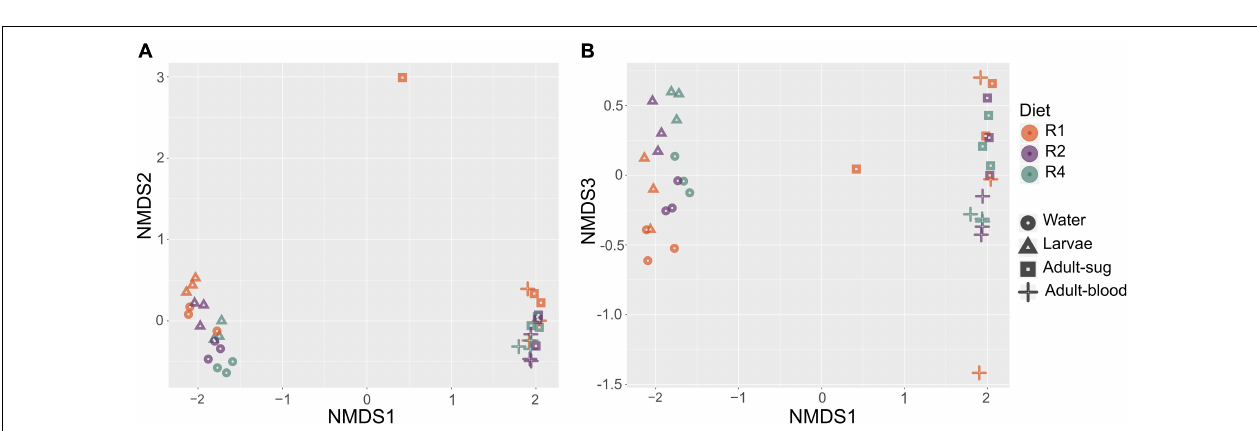
FIGURE 5 | Non-metric multidimensional scaling analysis reveals clustering by sample type and larval diet regimen. We performed NMDS analysis using Bray-Curtis dissimilarity values. Plots show axes 1 and 2 (A) and axes 1 and 3 (B) . Color is used to indicate diet regimen (orange = R1, purple = R2, green = R4) and shape is used to indicate sample type (circle = breeding water, triangle = larvae, square = adult sugar fed midguts, cross = adult blood fed midguts). Three biological replicate samples are plotted for each diet regimen-sample type